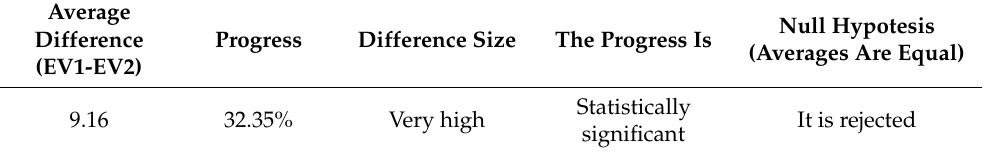
Table 4. Table of average differences of the Berg scale.